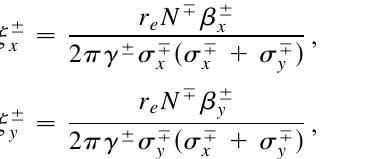
lowered to 1.25 cm [18] from the design value 1.5 cm [11].